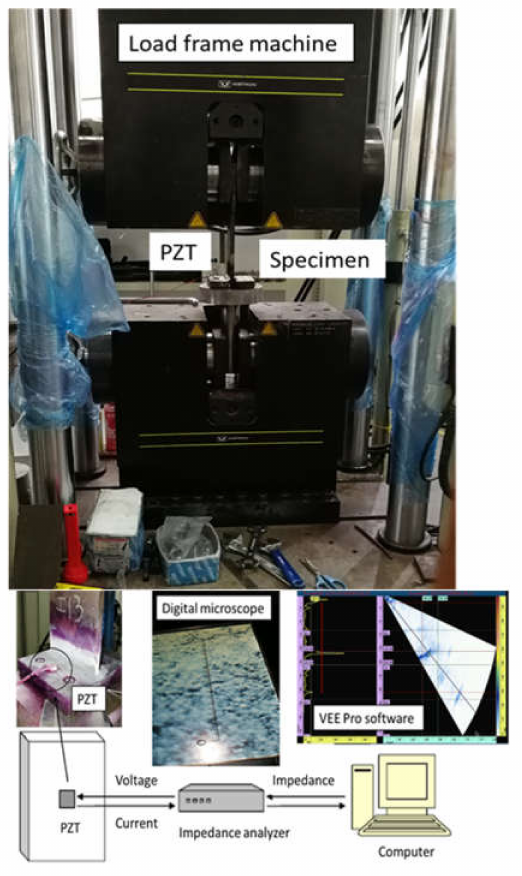
Figure 4. Experimental setup.